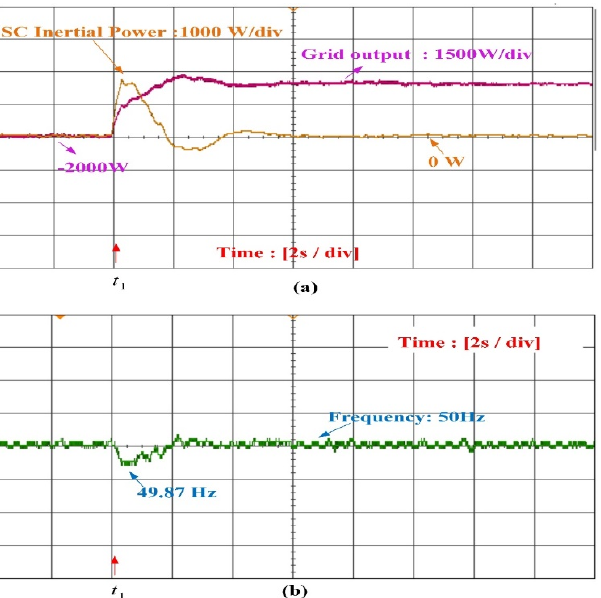
Figure 20. Load transition under constant irradiation ( a ) power from SC and grid; ( b ) frequency.